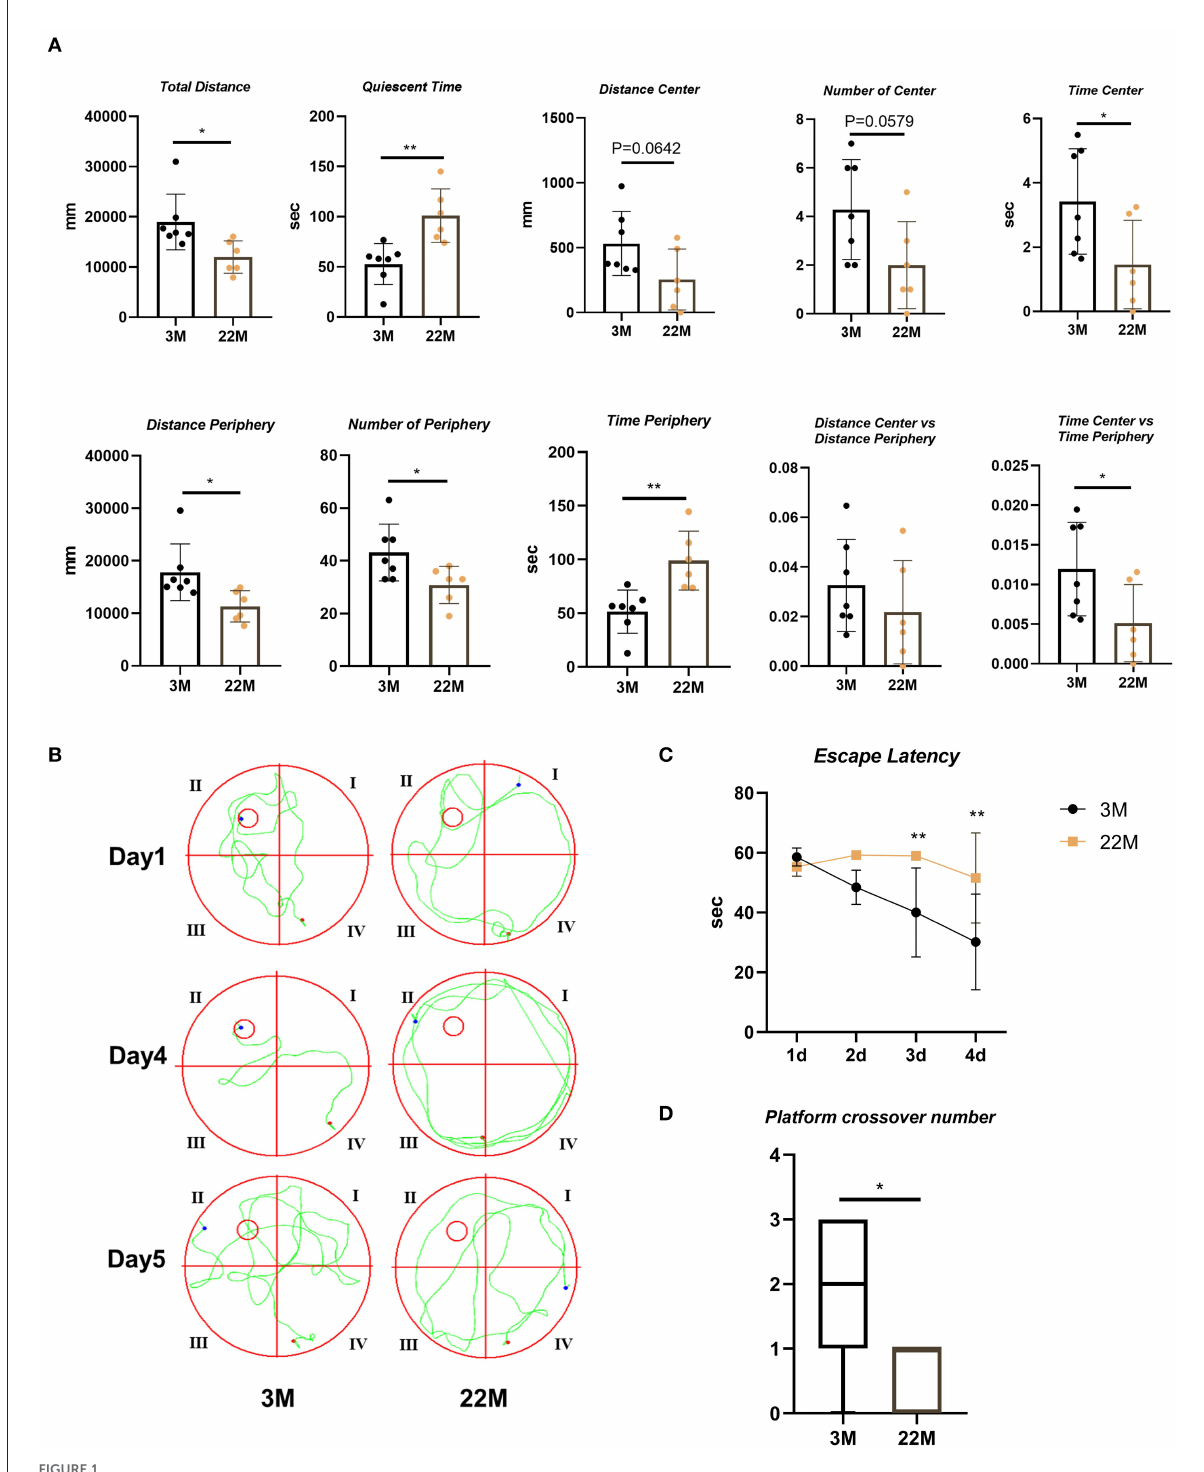
FIGURE1 Evaluation of exploration and spatial memory ability in aging mice. (A) The parameters of open field test between young (3M) and aging mice (22M) group. Data were represented as mean ± SD and were analyzed by Student t -test. * P < 0.05 and ** P < 0.01. (B) The locus diagrams of Morris water maze. Day 1th to Day 4th, Navigation test; Day 5th, Space exploration test. (C) Escape Latency in the navigation test of Morris water maze. Data were represented as mean ± SD and were analyzed by two-way analysis of variance (ANOVA) following Bonferroni’s multiple comparisons test. ** P < 0.01. (D) Platform crossover number in the space exploration test of Morris water maze. Mann-Whitney U test was employed and a box plot was used. * P <